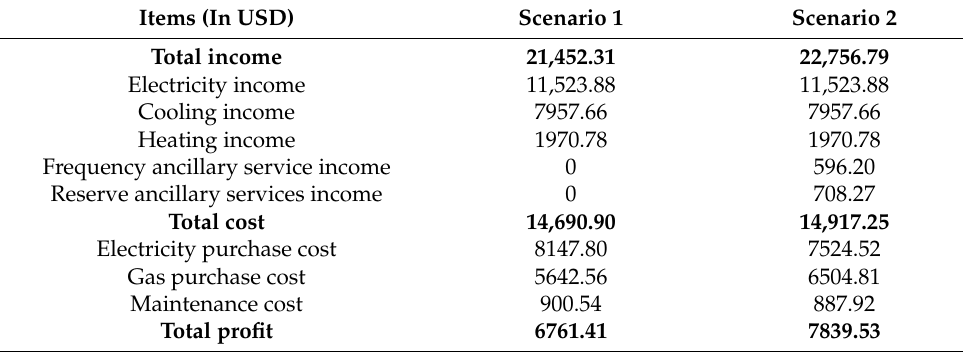
Table 4. Economic